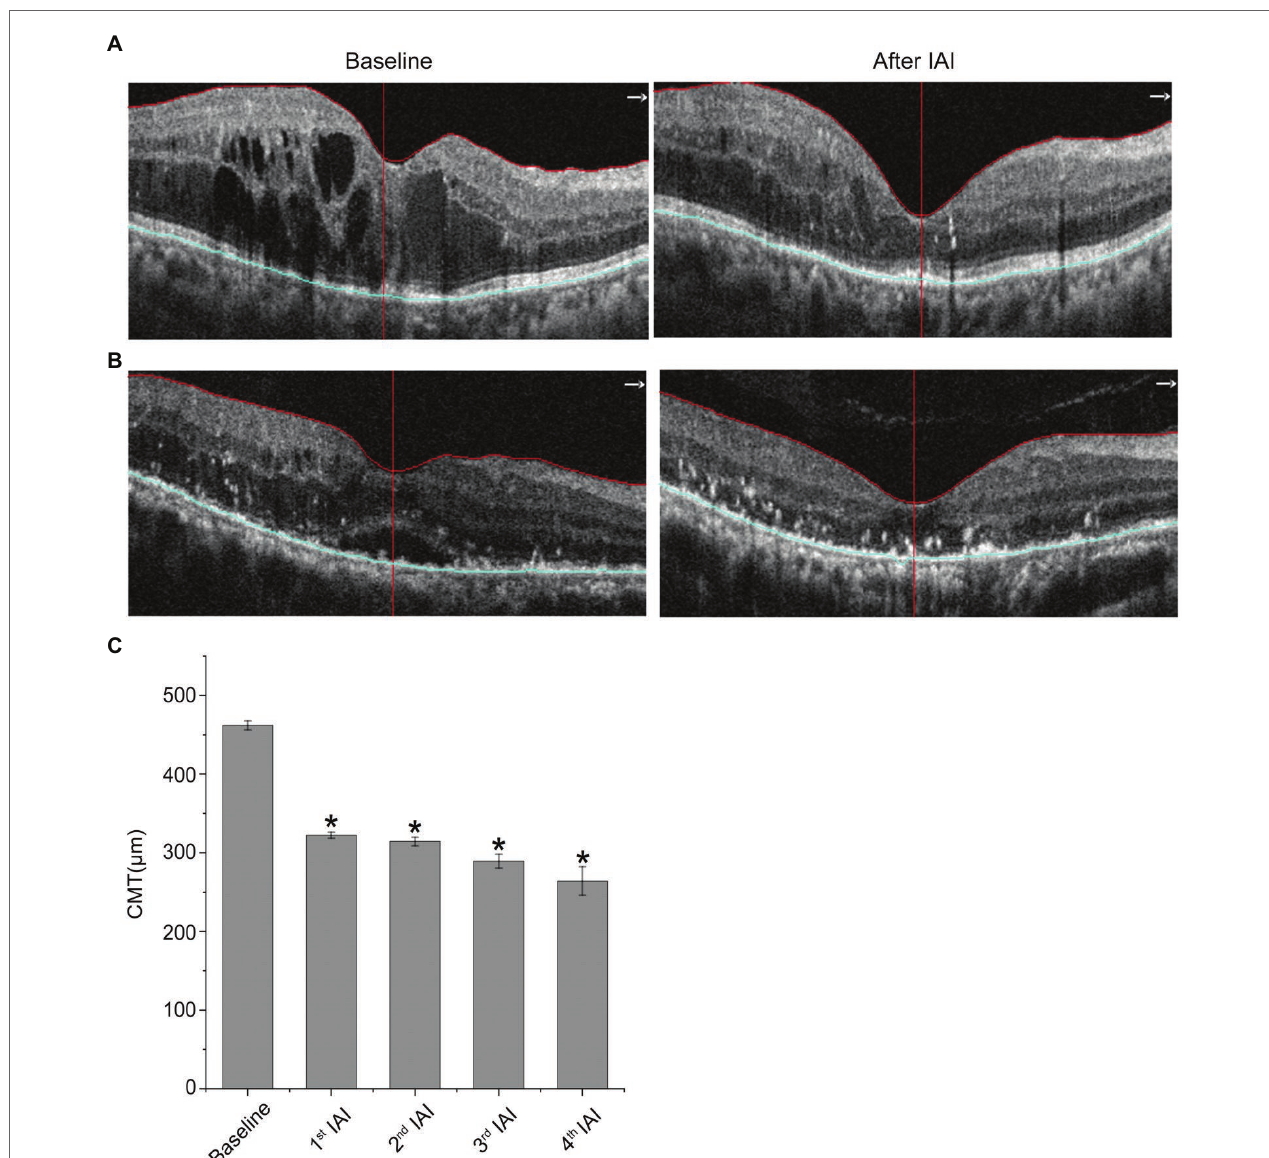
FIGURE 3 | CMT is decreased after IAI. (A) Representative images of a 77-year-old female patient with DME at baseline and after a monthly IAI. (B) Representative images of a 70-year-old male patient with DME at baseline and after a monthly IAI. (C) Decreased CMT following IAI. Data are mean ± SD. * p < 0.05 vs. baseline. CMT, central macular thickness and IAI, intravitreal aflibercept injection.